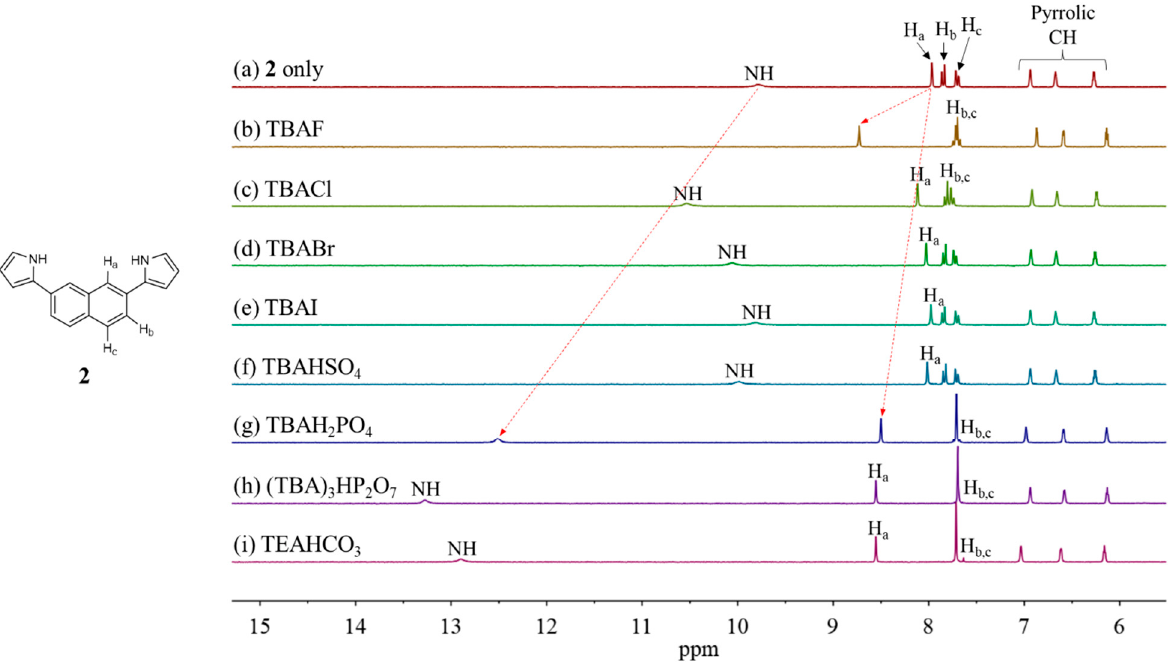
Figure 4. Partial 1 H NMR spectra of (a) 1 (3 mM) only, (b) 1 + excess TBAF, (c) 1 + excess TBACl, (d) 1 + excess TBABr, (e) 1 + excess TBAI, (f) 1 + excess TBAHSO 4 , (g) 1 + excess TBAH 2 PO 4 , (h) 1 + excess (TBA) 3 HP 2 O 7 , and (i) 1 + excess TEAHCO 3 in CD 3 CN.